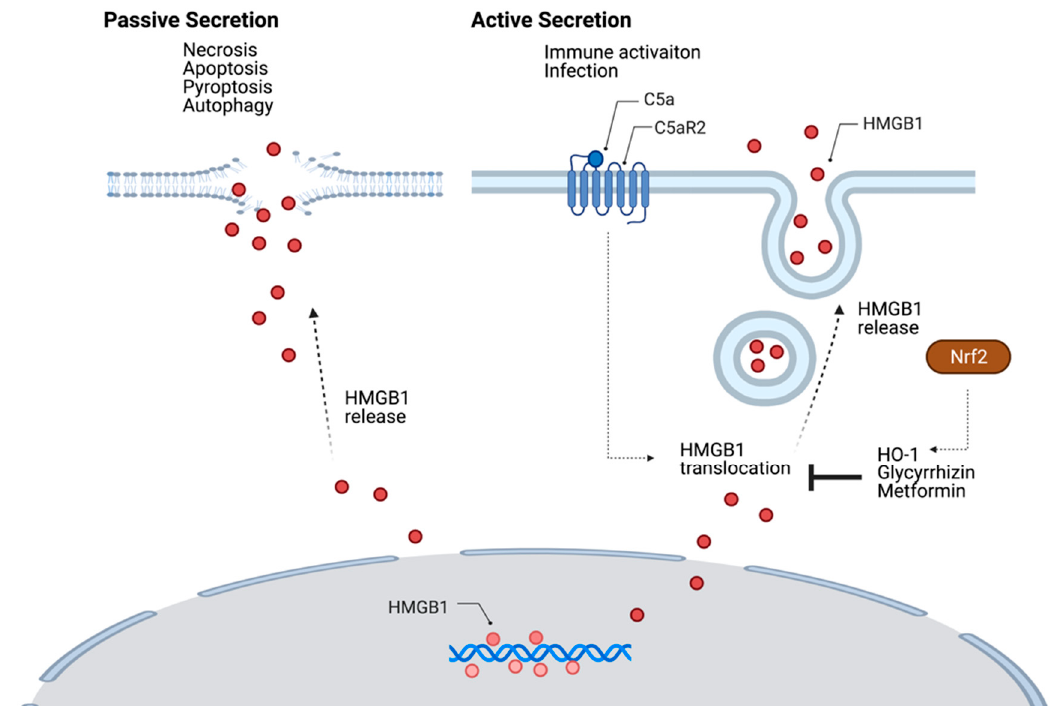
Figure 1. The regulation of HMGB1 secretion. Passive release of HMGB1 involves the plasma membrane disruption through cell death mechanisms. Inflammation and immune activation induce HMGB1 secretion. Post-translational modifications-mediated active secretion of HMGB1 occurs via secretory lysosomes. C5a and C5aR2 pathway induces HMGB1 release. Small molecules such as glycyrrhizin and metformin inhibit nuclear HMGB1 translocation to the cytosol. The nuclear factor-erythroid 2-related factor 2 (Nrf2)/hemeoxygenase-1 (HO-1) pathway also suppresses the translocation and secretion of HMGB1.